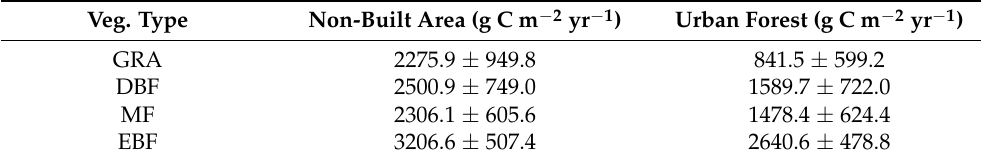
Table 3. Differences in yearly GPP between vegetation in non-built areas and built